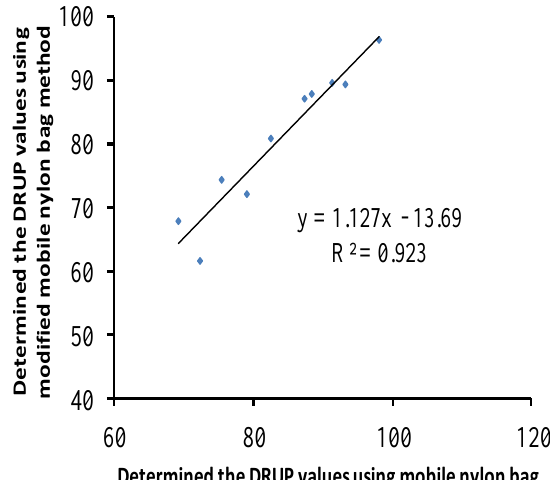
Figure 3. Predicted analysis between MNB observed values and OTS observed value in the concentrates. DRUP, digestibility of rumen undegradable protein; MNB, mobile nylon bag method; OTS, original three-step in vitro method.